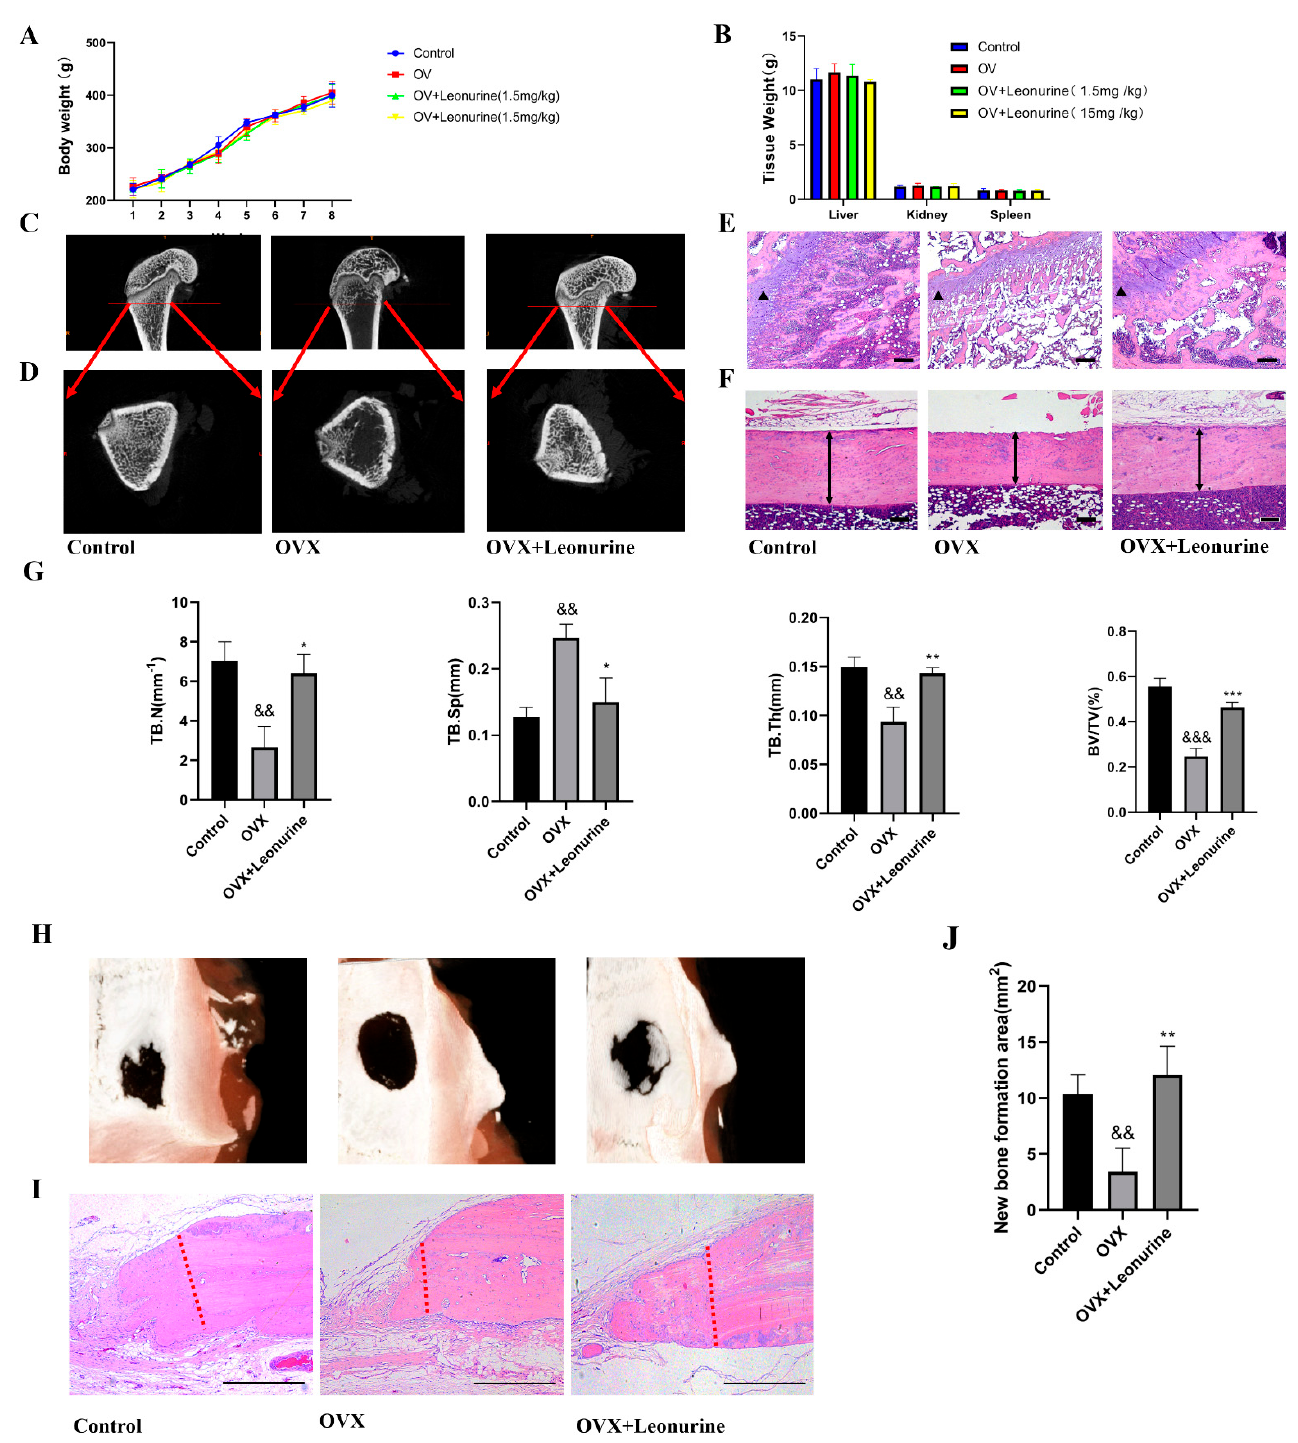
Figure 7. Leonurine ameliorates osteoporosis and contributes to osteogenesis in vivo. ( A ) Body weight. ( B ) Organic weight. ( C ) MicroCT of the femur on longitudinal section. ( D ) MicroCT of the femur on transection; ( E ) H&E staining of the femur on cancellous bone. ( F ) H&E staining of the femur in cortical bone. ( G ) MicroCT assessment evaluated for: Tb.N trabecular number; Tb.S trabecular spacing; Tb.Th trabecular thickness; BV/TV trabecular bone volume fraction; ( H ) Skull bone defect healing condition. ( I ) H&E staining of new bone formation. ( J ) Quantitative analysis of the new bone formation area. (&& p < 0.01, &&& p < 0.001 vs. Control group. * p < 0.05, ** p < 0.01, *** p < 0.001 vs. H 2 O 2